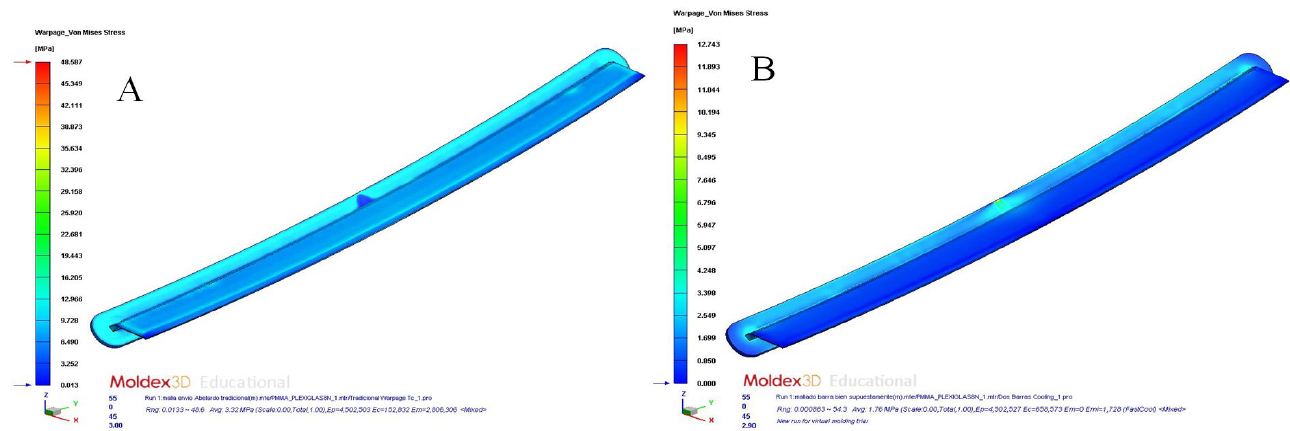
Figure 19. Warpage stress (MPa); straight drilled channels ( A ), conformal channels—Fastcool full bars ( B ).